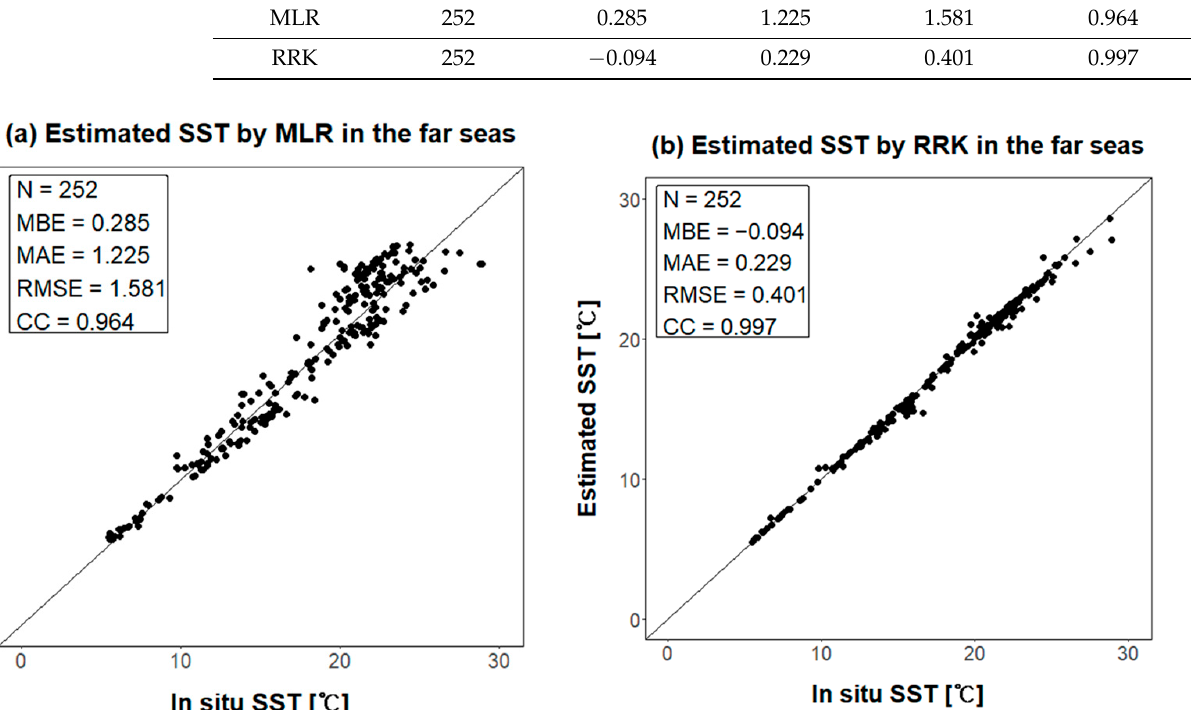
Table 7. Null pixel ratio of GK2A daily SST in 2020.